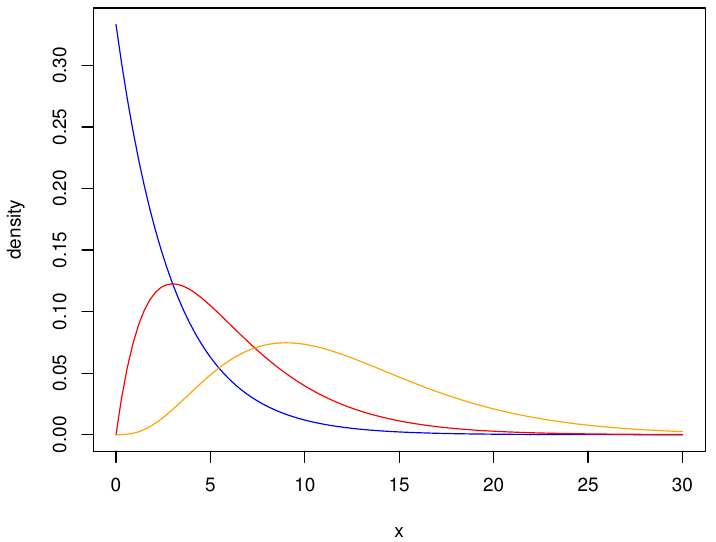
= 3 ) probability distributions of varied shape and skew used in performance Figure 2. Gamma ( γ , 1 λ analysis and representing the range of many control chart applications. γ = 1 (blue), γ = 2 (red), and γ = 4